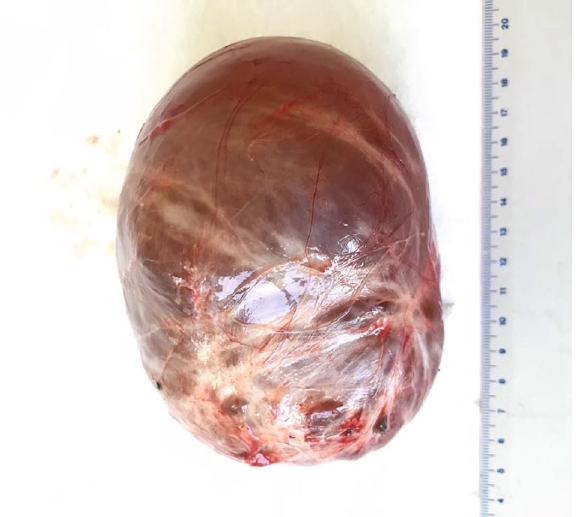
Figure 3: Complete excision of the cyst.